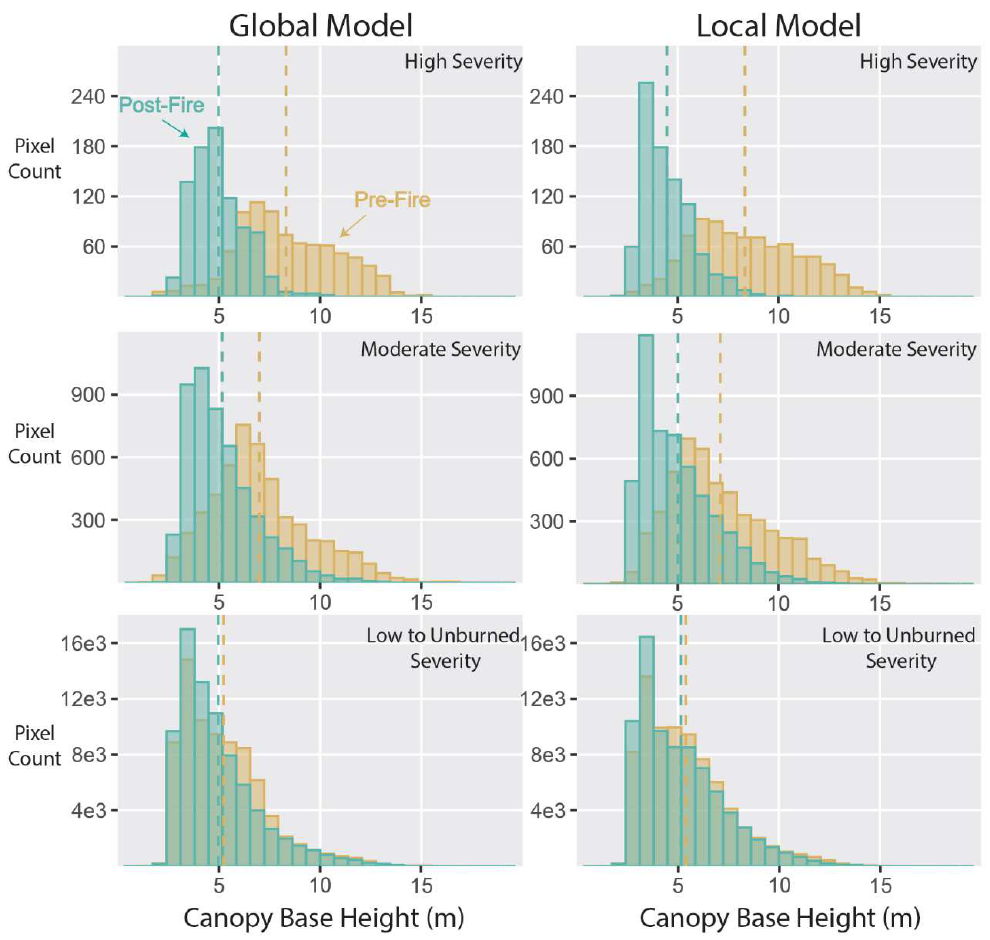
Figure 12. Comparison of pre- and post-fire, global and local (Ochoco) model predictions for canopy base height in high ( top row ), moderate ( middle row ), and low to unburned ( bottom row ) fire severity classes for the Corner Creek Fire. Vertical dotted lines depict the mean prediction value.